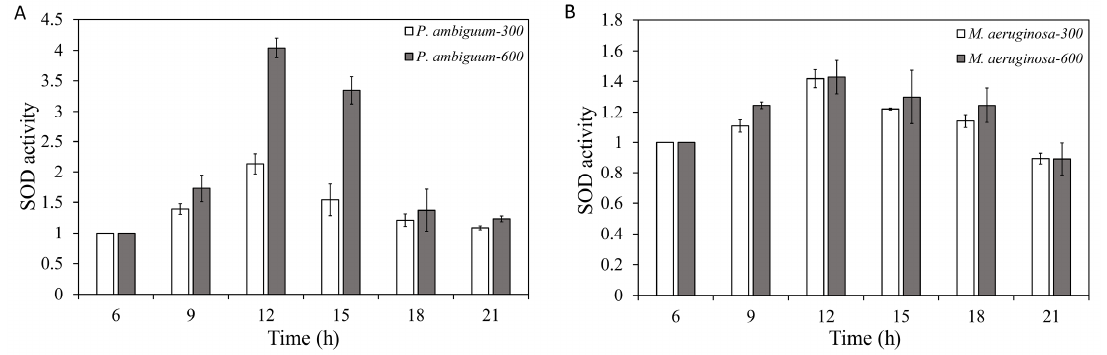
Figure 5. Diurnal variations in the super oxidase dismutase (SOD) activities of P. ambiguum (strain NIES 2119) ( A ) and M. aeruginosa (strain NIES 111) ( B ). The numbers 300 and 600 represent the maximum PAR intensities (in µ mol·m −2 ·s −1 ) for two different treatment conditions, where the maximum PAR intensity was reached at 12:00 h. The error bars represent the standard deviations.